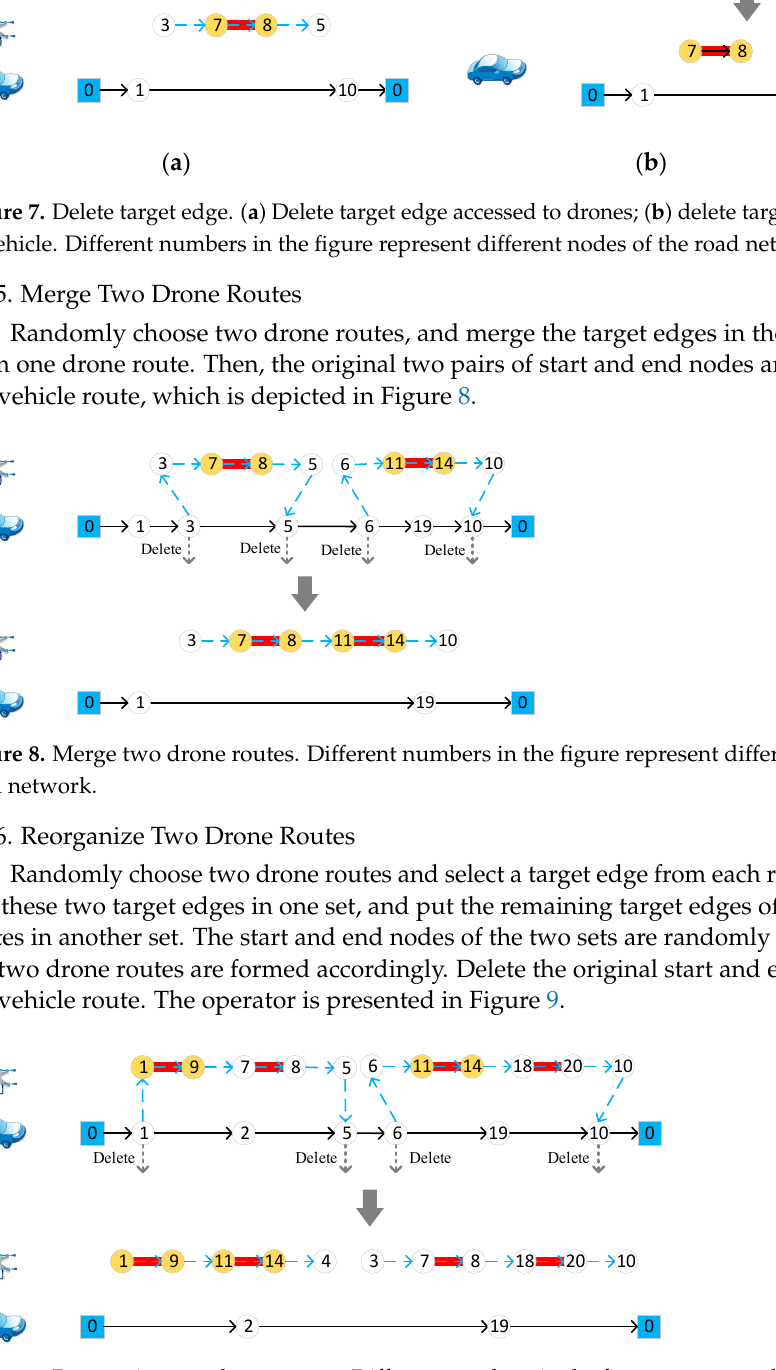
Figure 9. Reorganize two drone routes. Different numbers in the figure represent different nodes of the road network.